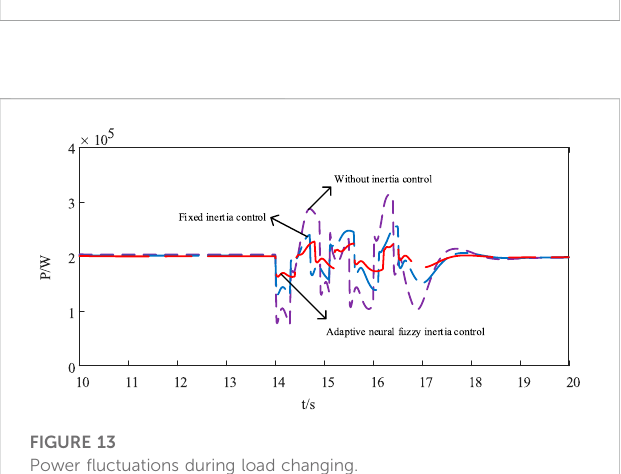
FIGURE 12 Power fl uctuations during load decreasing.